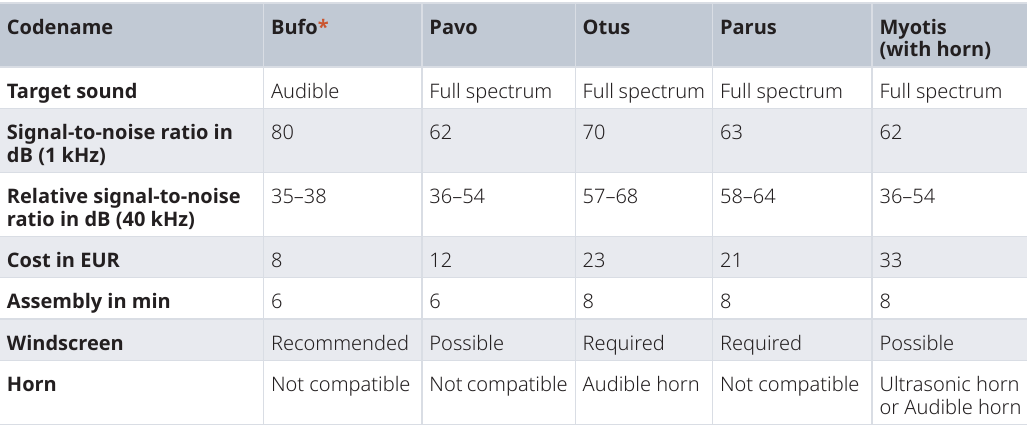
Table 2. Different microphone designs with their characteristics. Complete data are available from the Open Science Framework 14 . Costs and assembly times are broken down in Table 1 . * this design uses the PUI audio AOM-5024L-HD-R microphone